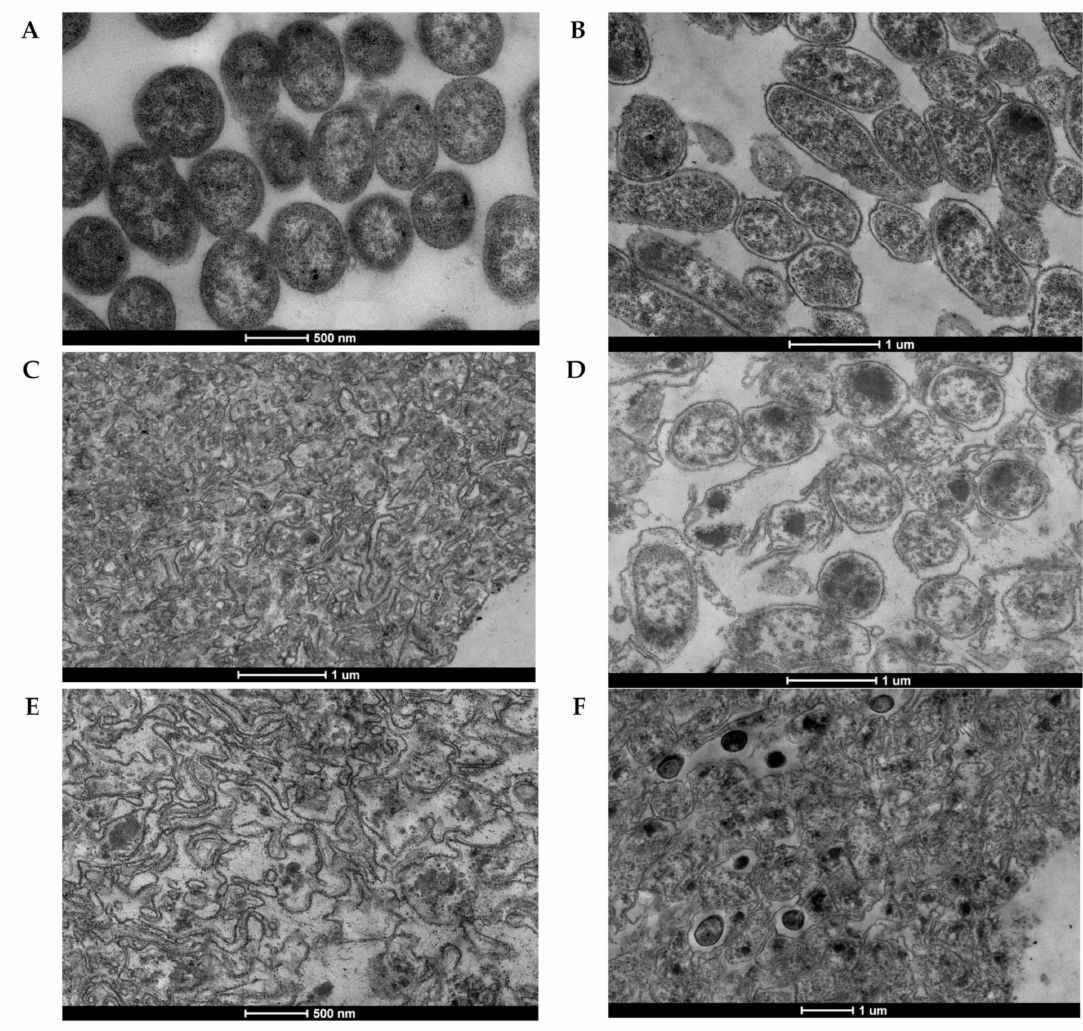
Figure 3. Transmission electron micrographs of Y. pestis strains ( A ) KM260(12) ∆ lpxM, ( B ) KM260(12) ∆ lpxM) pEYR’-E, ( C ) KM260(12) ∆ lpxM/pEYR’-Y-K, ( D ) KM260(12) ∆ lpxM/pEYR’- S-R-Rz KM260(12) ∆ lpxM/pEYR’-S-R-Rz, ( E ) KM260(12) ∆ lpxM/pEYR’E-Y-K, ( F ) KM260(12) ∆ lpxM pEYR’-E-S-R-Rz. (24 h after the induction).The bar represents 0.1 µ m ( B – D , F ) or 500 nm ( A , E